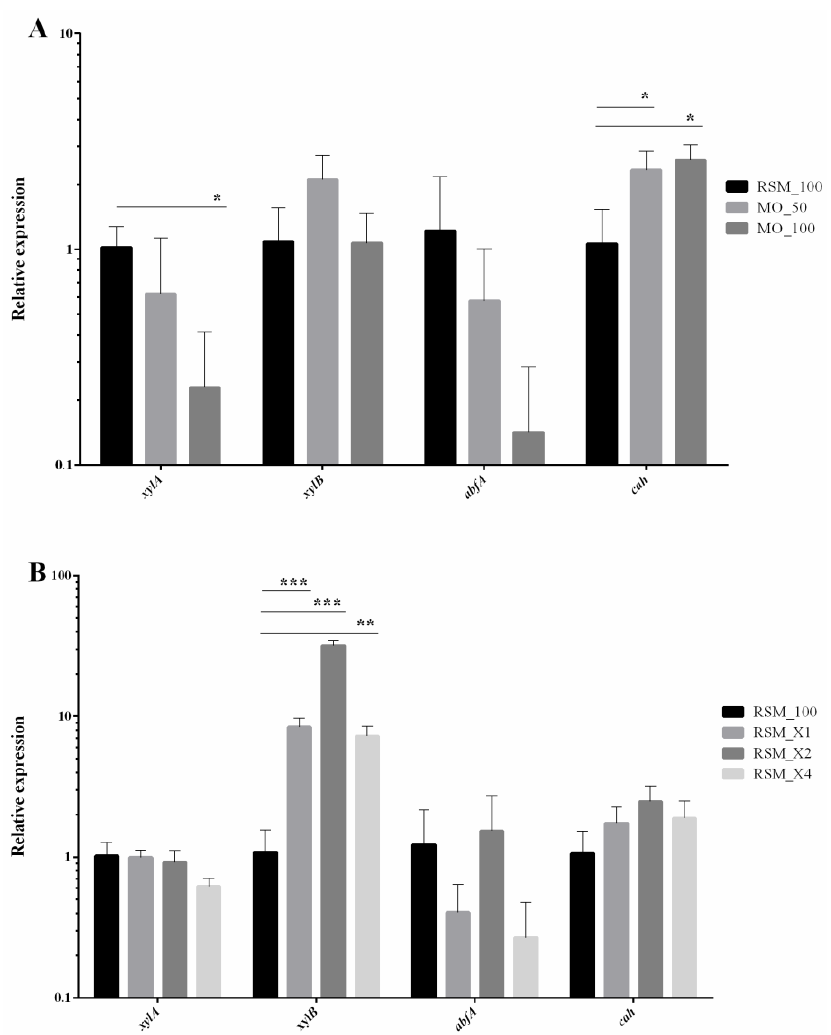
Figure 4. Relative expression of specific xylanases found in B. subtilis 87Y genome. ( A ) SSF samples on RSM/MO mixture; ( B ) SSF samples on RSM with xylan substitution (instead of sucrose) in liquid medium as carbon source of 10, 20 or 40 g/L. xylA— endo-β-xylanase; xylB— β–xylosidase; abfA— α – arabinofuranosidase; cah— acetylxylan esterase. Results are shown in log 10 values. Statistical significance in all cases is presented as follows: * p < 0.05; ** p <0 .01; *** p <